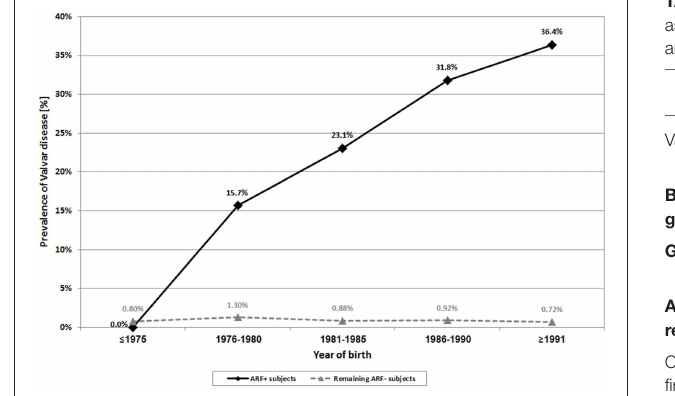
Those variables significantly associated with ARF were entered